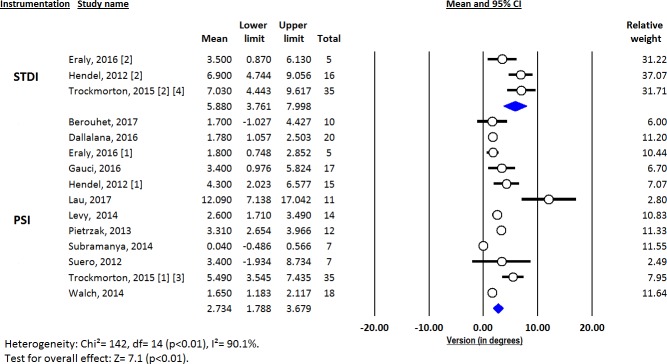
Forest plot of version deviation from the pre-operative planning, for all included studies.